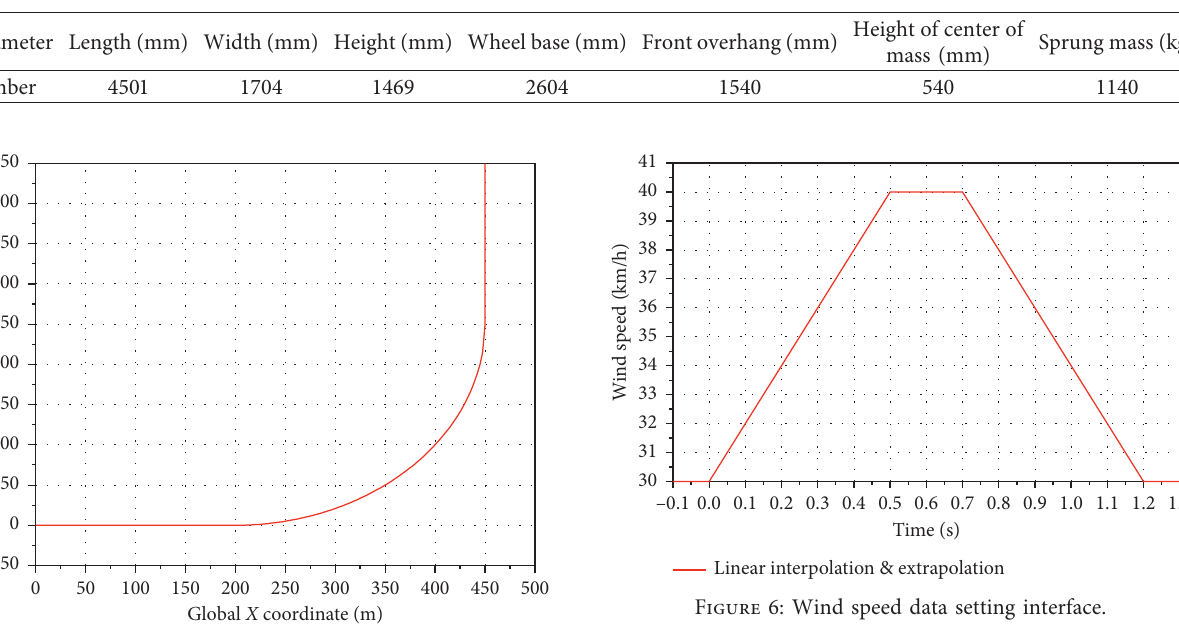
Figure 5: Plane alignment of the road model.